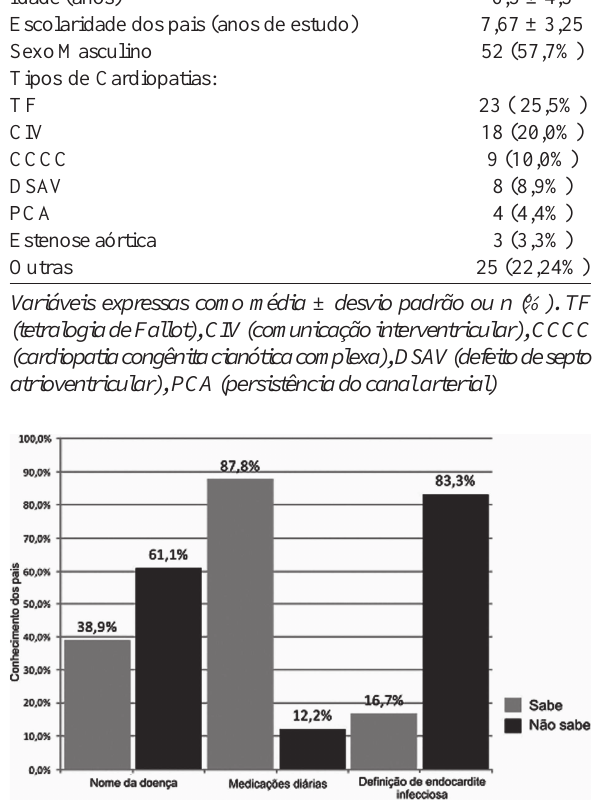
Fig. 1 – Questões relativas ao conhecimento da